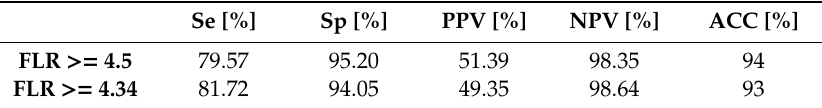
Table 9. Optimal FLR values—diagnostic